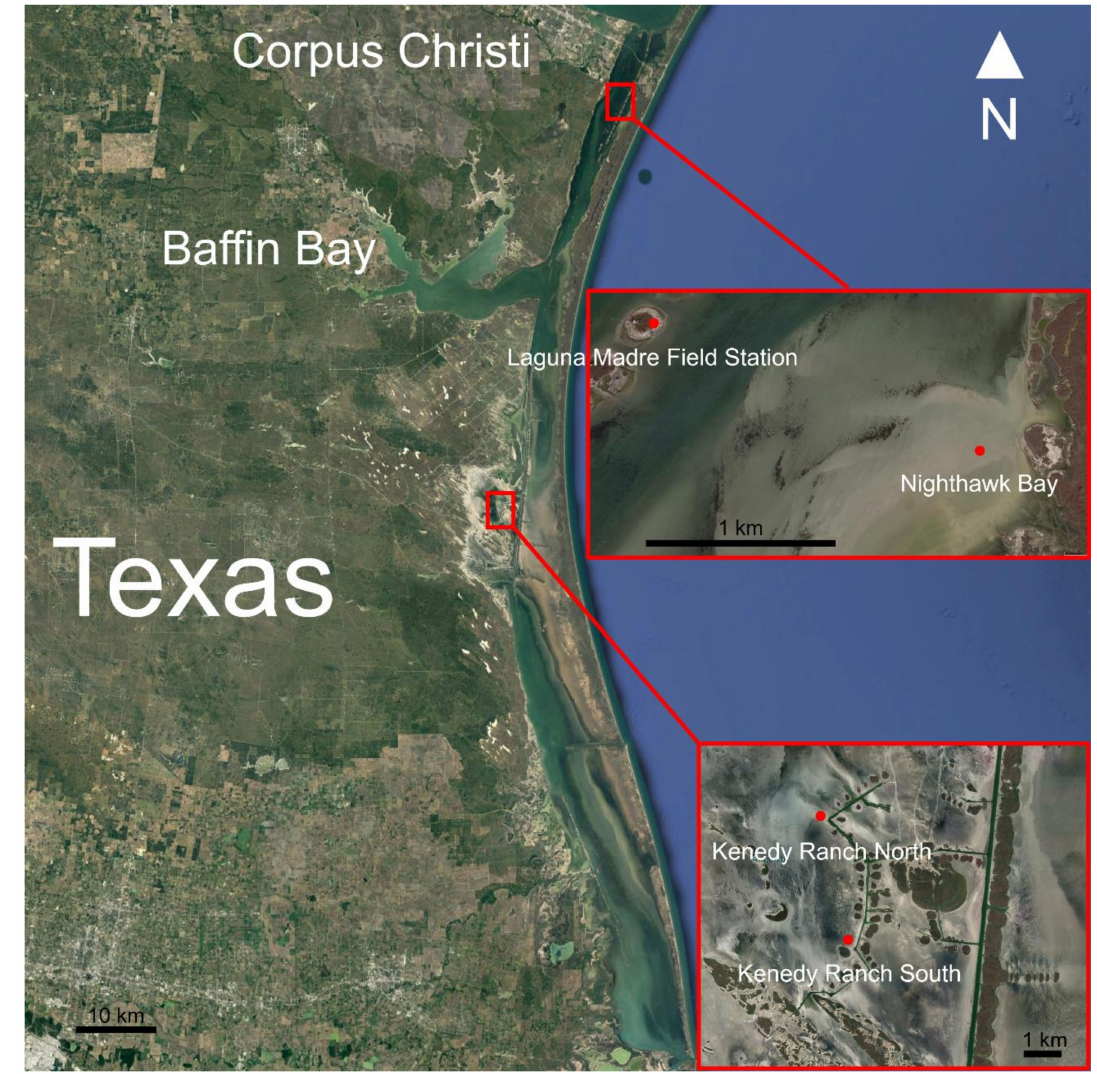
Figure 1. Map of the Laguna Madre showing the sample